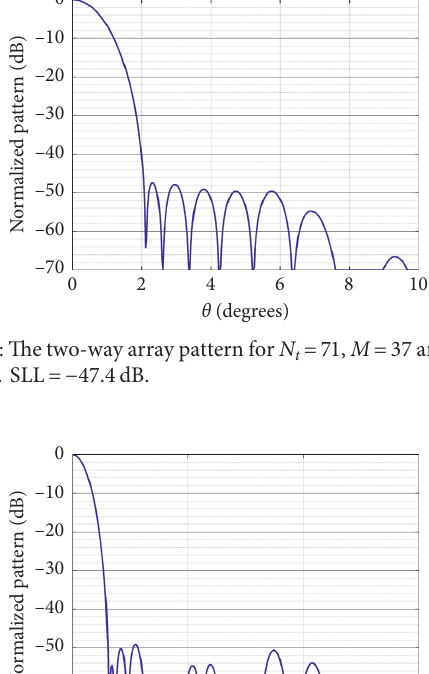
� 48, M � 24 and N t